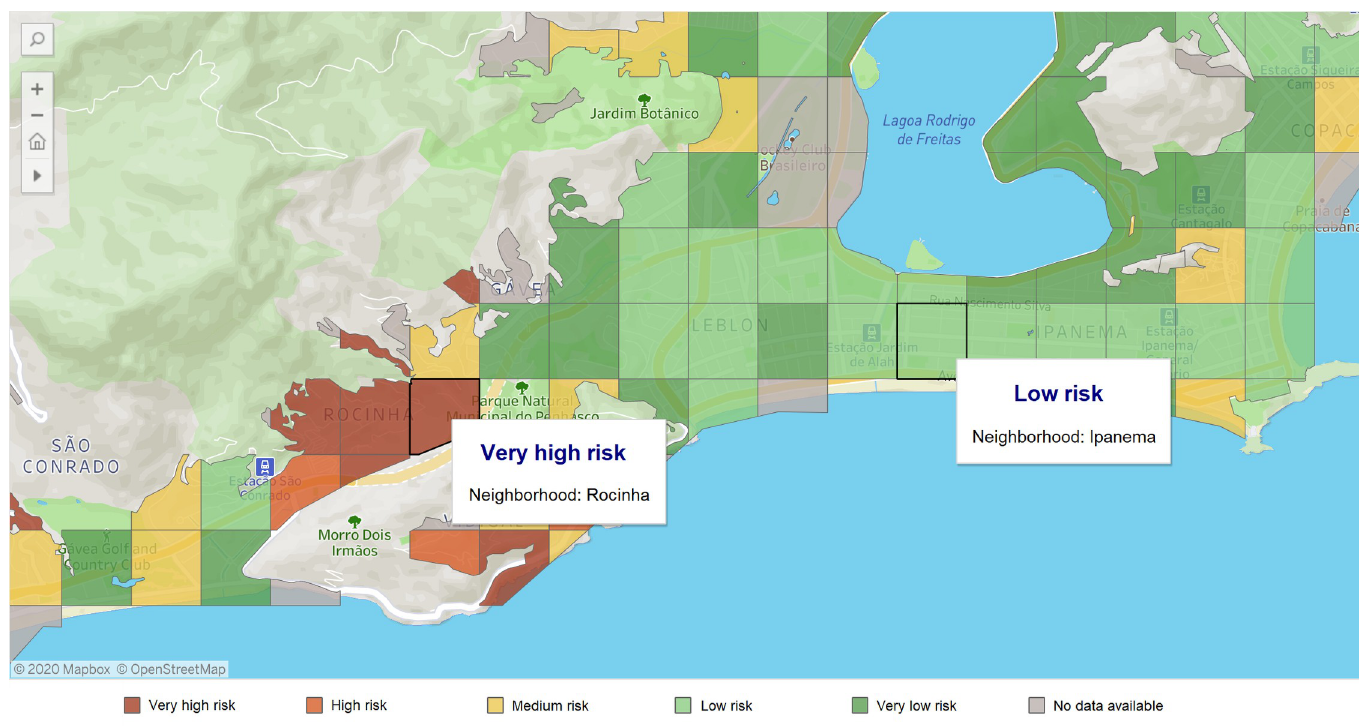
Fig 5. Risk map of two neighborhoods of Rio de Janeiro (Rocinha–very high risk and Ipanema–low risk). Map created by Dados do Bem app using OpenStreetMap @ 2020Mapbox.